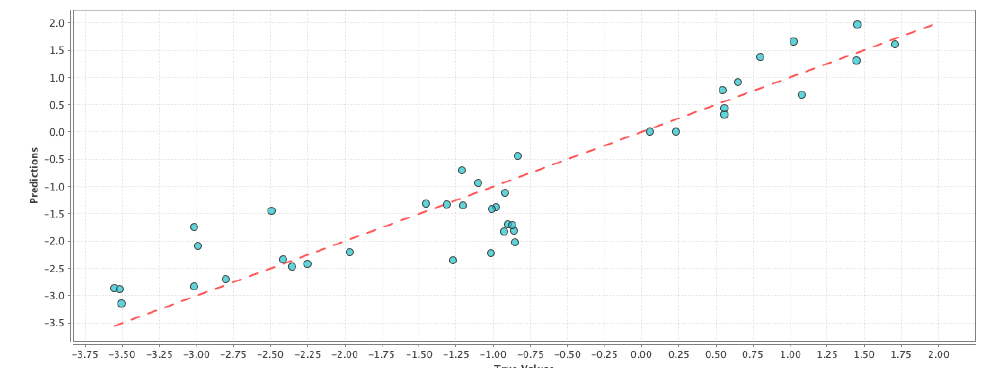
Figure 3. Same as Figure 1 but for Deep Learning model.